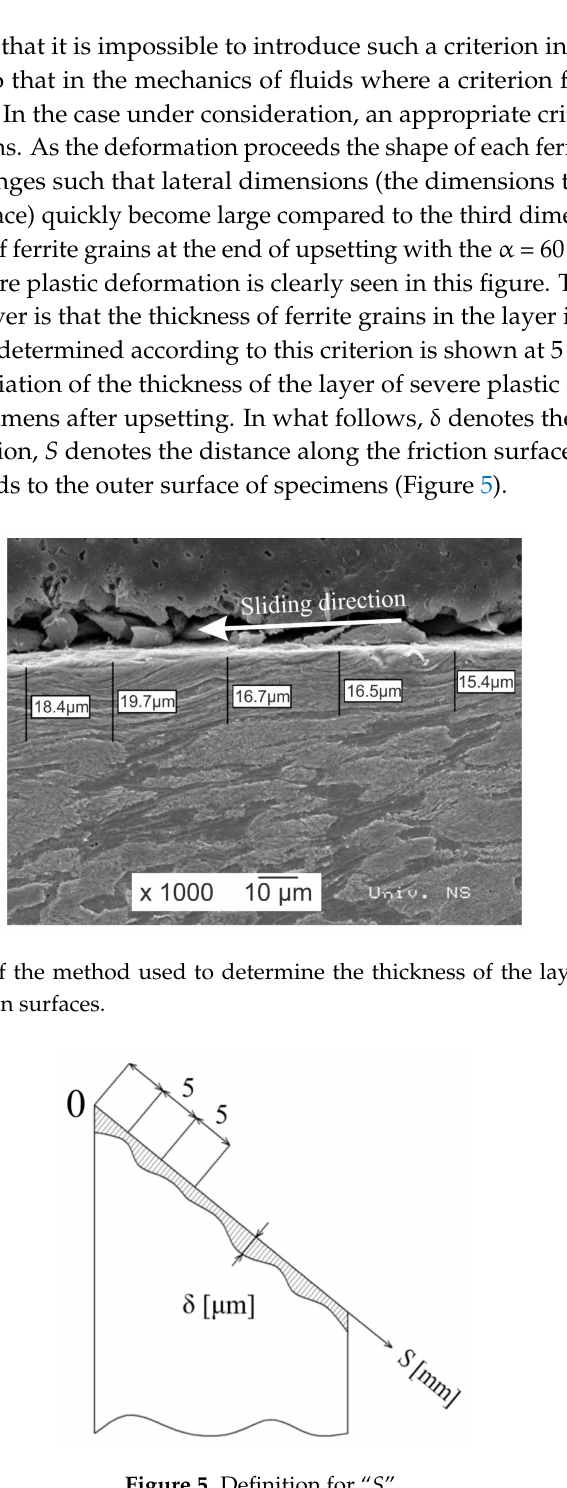
Figure 5. Definition for “ S